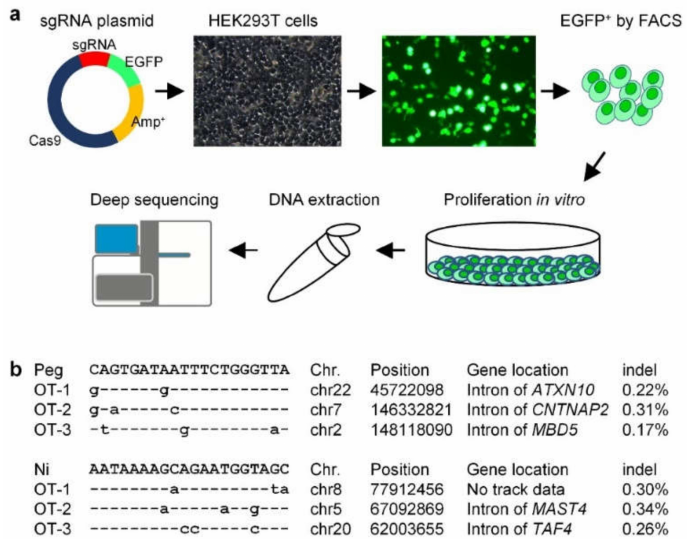
Figure 4. Off-target analysis of PE3 used for IVS-II-654 correction within the human genome. ( a ) Workflow of off-target analysis. Briefly, a plasmid containing Cas9, sgRNA, and the reporter gene enhanced green fluorescent protein ( EGFP ) was constructed and transferred into human HEK293T cells. EGFP- positive HEK293T cells were collected using fluorescence-activated cell sorting, and then proliferated in vitro to extract genomic DNA for deep sequencing of off-target edits. ( b ) According to the deep-sequencing data, the sequence, genome position, gene location, and edits (indels) of the off-targets were analyzed. Peg and Ni indicate spacer sequences of pegRNA (Peg) and nick sgRNA (Ni), respectively; OT indicates